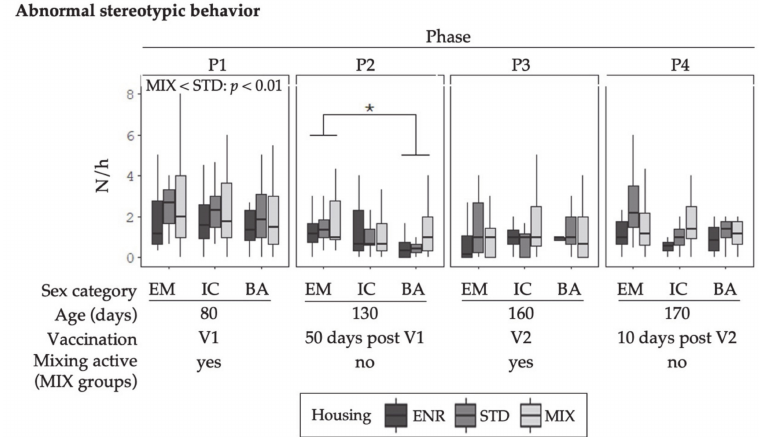
Figure 4. Mean number of occurrences (N) of abnormal stereotypic behaviors per hour (h) for each animal are given as boxplots for the sex categories in the different environments. Columns represent the data of animals in four different behavior observation phases (P1–P4). V1 represents phases before, and V2 after the second immunization of IC. The MIX pens were mixed in P1 and P3. Note: no mixing was done in STD and ENR at any time. Sex categories were: EM = entire males, IC = immunocastrates, BA = barrows; Housing environments were: ENR = enriched, STD = standard, MIX = mixing. Significant differences between sex categories are indicated by asterisks (*** p < 0.001, ** p < 0.01, * p < 0.05), whereas for tendencies p -values are given. Housing differences are annotated with p -values in the graphs respectively. Boxplots show the minimum with respect to the interquartile range, the 25th percentile, the median, the 75th percentile and the maximum value with respect to the interquartile